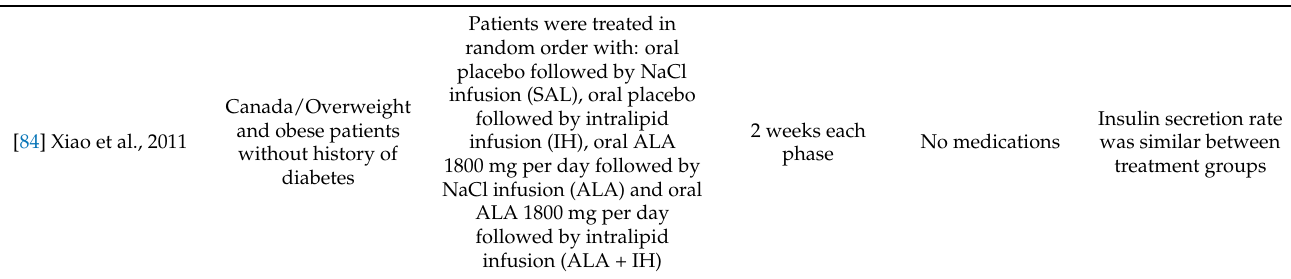
Table 3. Studies on ALA’s effect on insulin secretion (ISR)